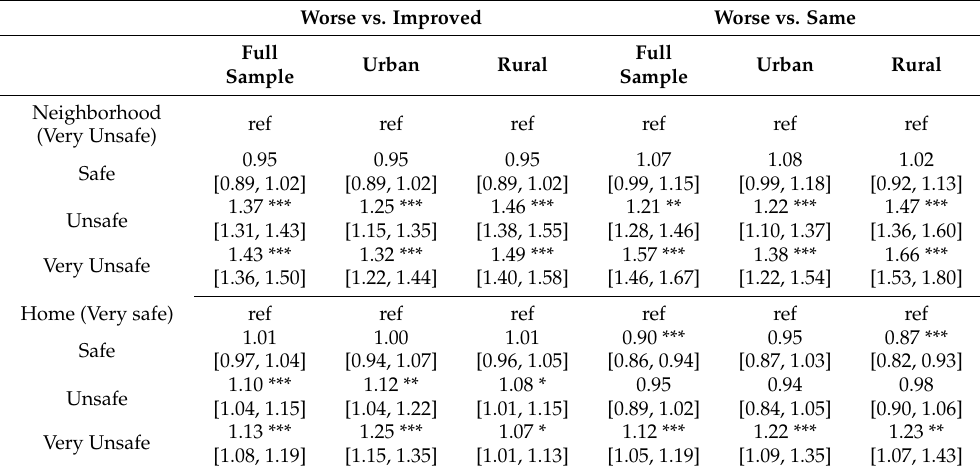
Full Urban Rural Sample